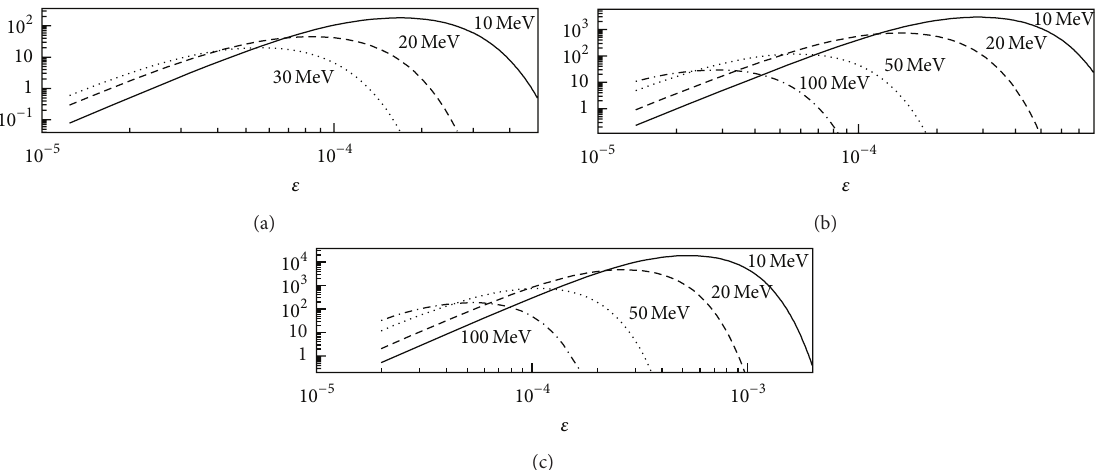
Figure 3: Same as Figure 2, with the further request that the transverse decay path is lower than 5cm.